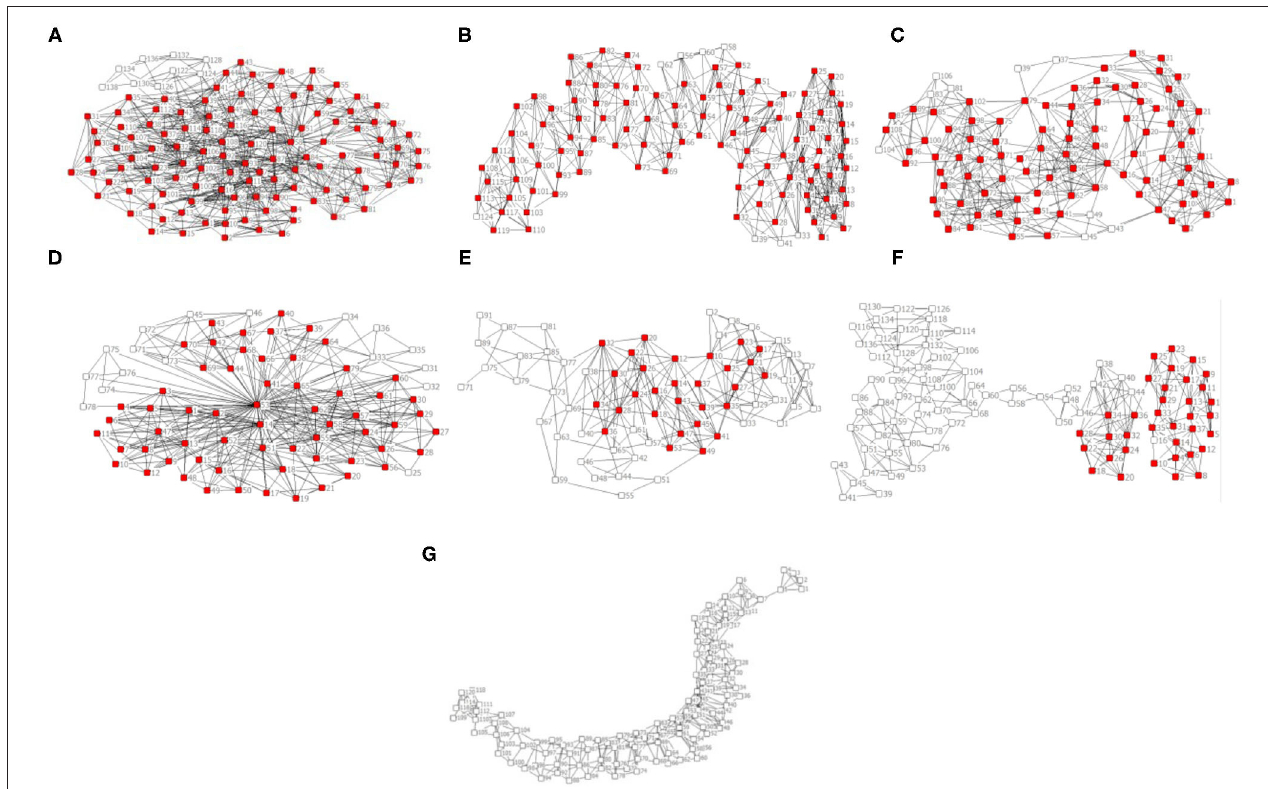
FIGURE 3 | Distribution topology of 6-core of historical towns (red color ≥ 6-core, white color <6-core). (A) Zhongshan, ZS; (B) Baisha, BS; (C) Wenquan, WQ; (D) Pianyan, PY; (E) Qingyang, QY; (F) Ningchang, NC; (G) Xituo, XT.